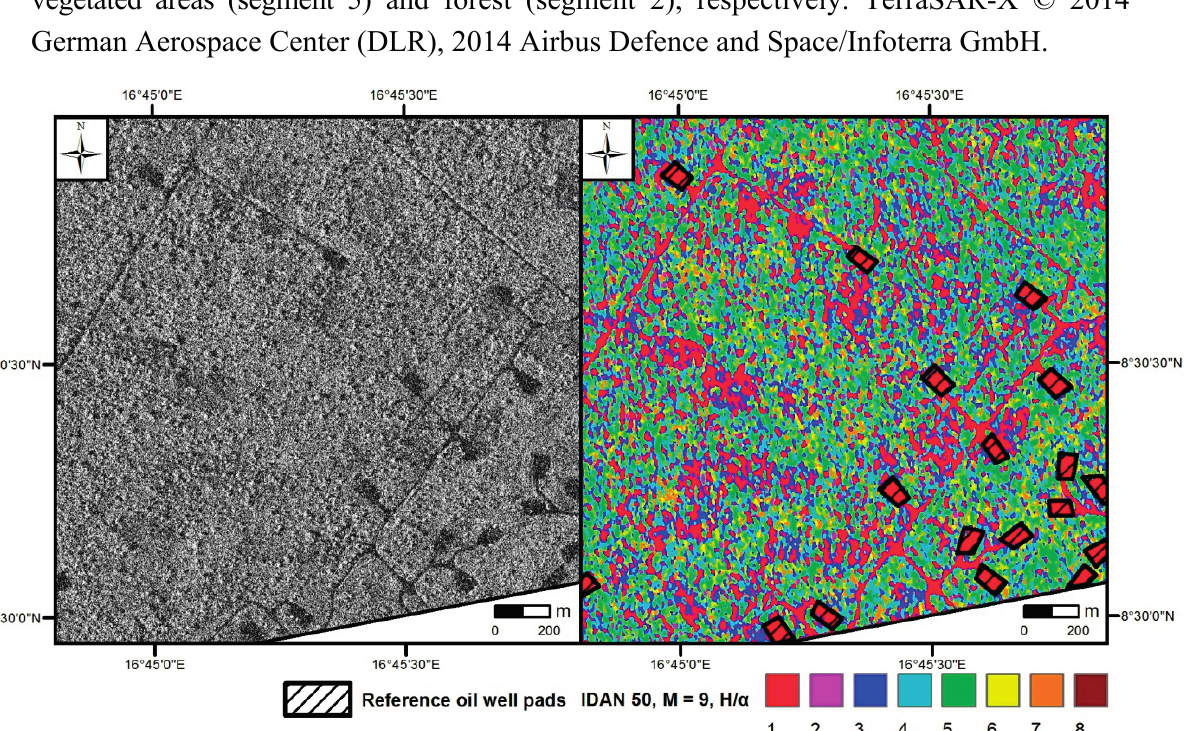
Figure 5. Subset of the study area. Left: Original TerraSAR-X acquisition (5 September 2010). Right: Best result of the pixel-based Wishart classification. This first classification step is based on H/ α (with M = 9) using the IDAN filter (with 50 pixel max. region